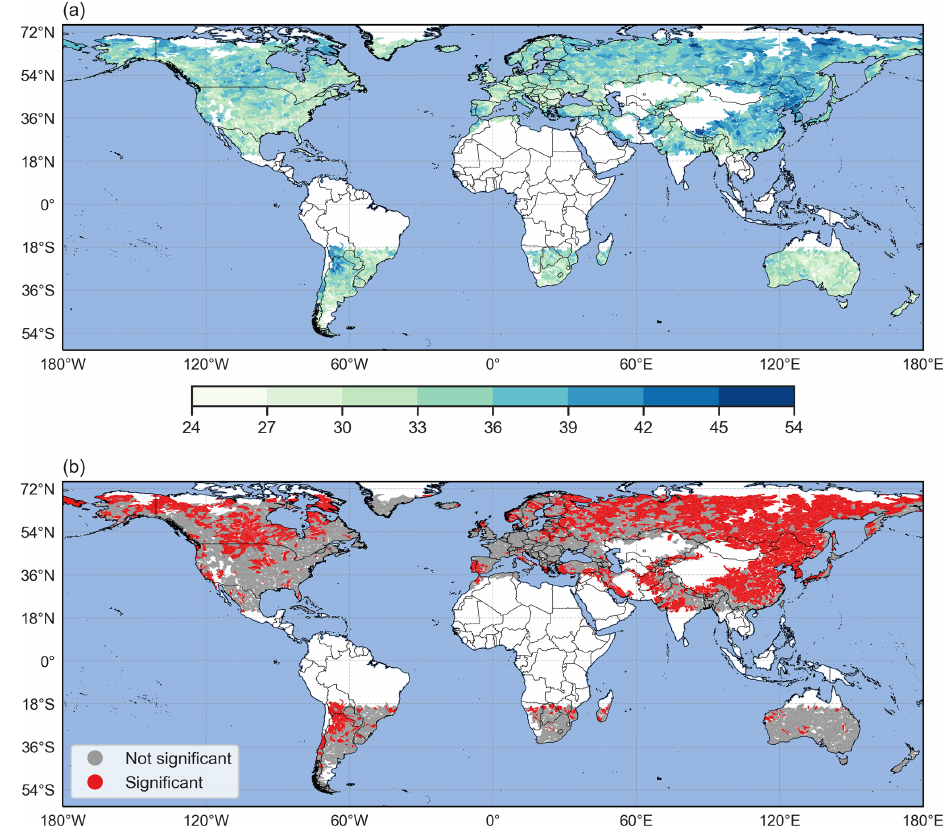
Figure 6. Metric S cl (a) and sub-seasonal clustering significance (b) by catchment, for r = 2d, t = 99p and w = 21d. In (a) , high values of S cl denote catchments where sub-seasonal clustering is prevalent. In (b) , catchments where S cl is significantly higher than for a distribution of extremes events without temporal structure are shown in red at the 1%